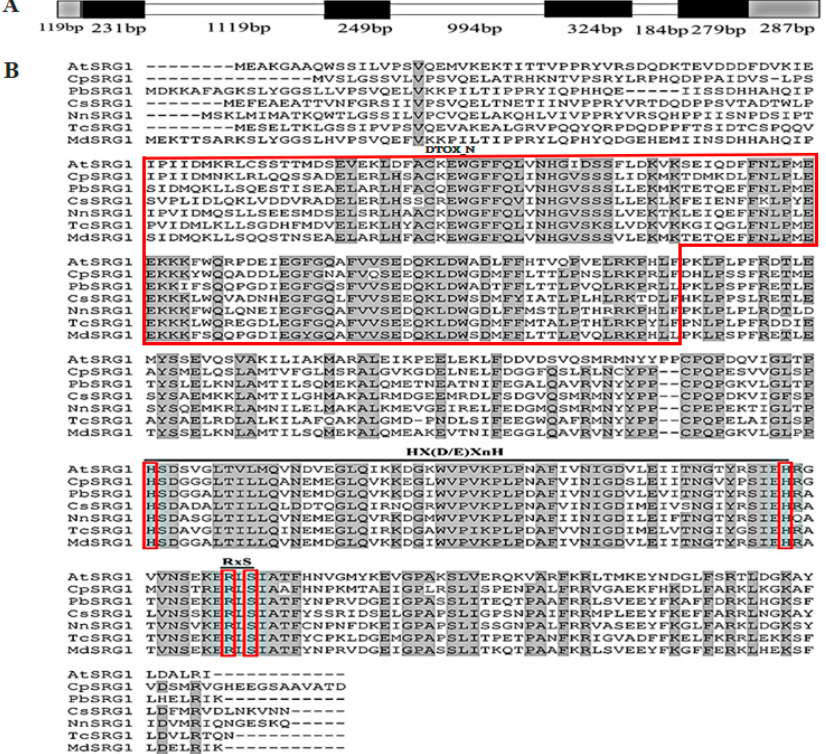
Figure 1. Sequence analysis of CpSRG1. ( A ) Schematic diagram of the CpSRG1 gene. Exons are indicated by black areas, introns are indicated by white areas, and untranslated regions are indicated by gray areas. ( B ) Multiple alignment of CpSRG1 and other SRG1 proteins from different plant species. Arabidopsis thaliana AtSRG1 (NP_173145), Pyrus bretschneideri PbSRG1 (KAB2605442.1), Citrus sinensis CsSRG1 (XP_006477808.1), Nelumbo nucifera NnSRG1-LIKE (XP_010273388.1), Theobroma cacao TcSRG1 (EOY13557.1), and Malus domestica MdSRG1-LIKE (XP_028944961.1). Identical and similar amino acids are shaded in black. The conserved Hx(D/E) XnH motif, RxS motif, and DIOX_N are marked by a red